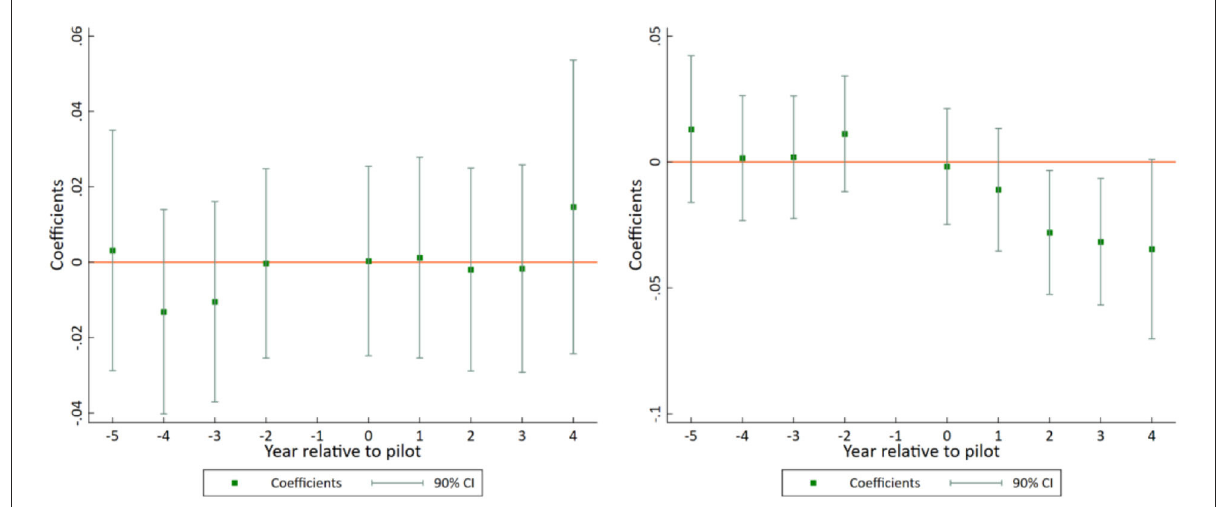
FIGURE3 Parallel trend test of ln ME_outpatient (left) and ln ME_inpatient (right)